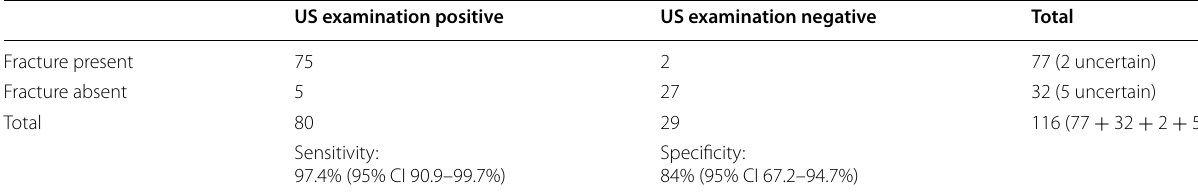
Table 4 Sensitivity and specificity for US to detect any fracture type US examination positive US examination negative Fracture